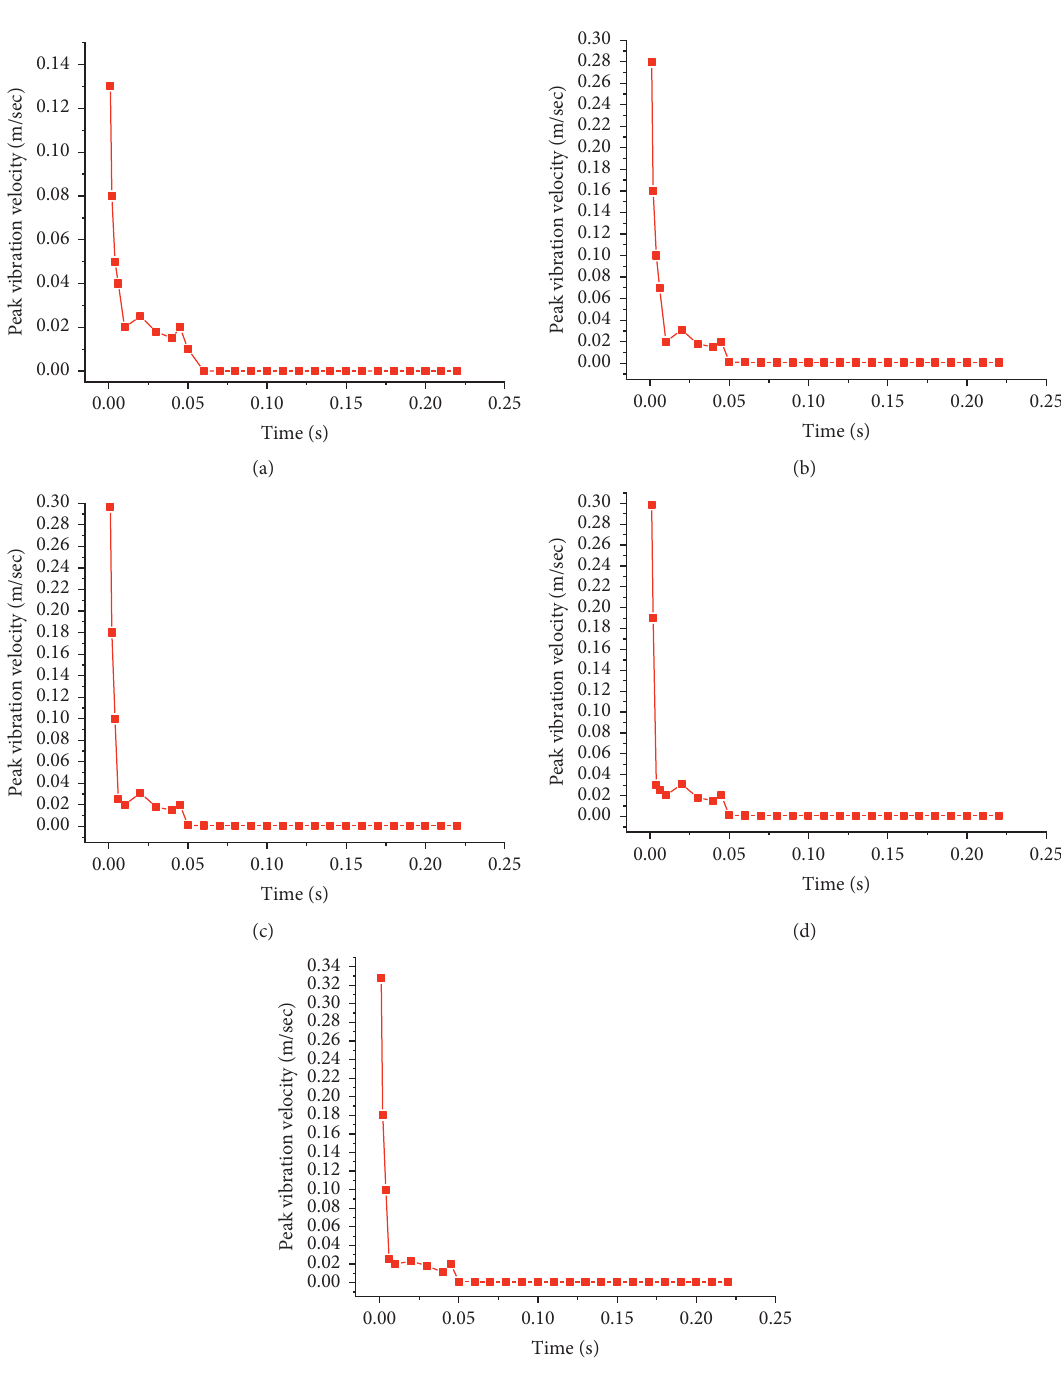
Figure 7: Vibration velocity change of the arch bottom measuring point at profile 1-1. (a) First blast. (b) Second blast. (c) Third blast. (d) Fourth blast. (e) Fifth